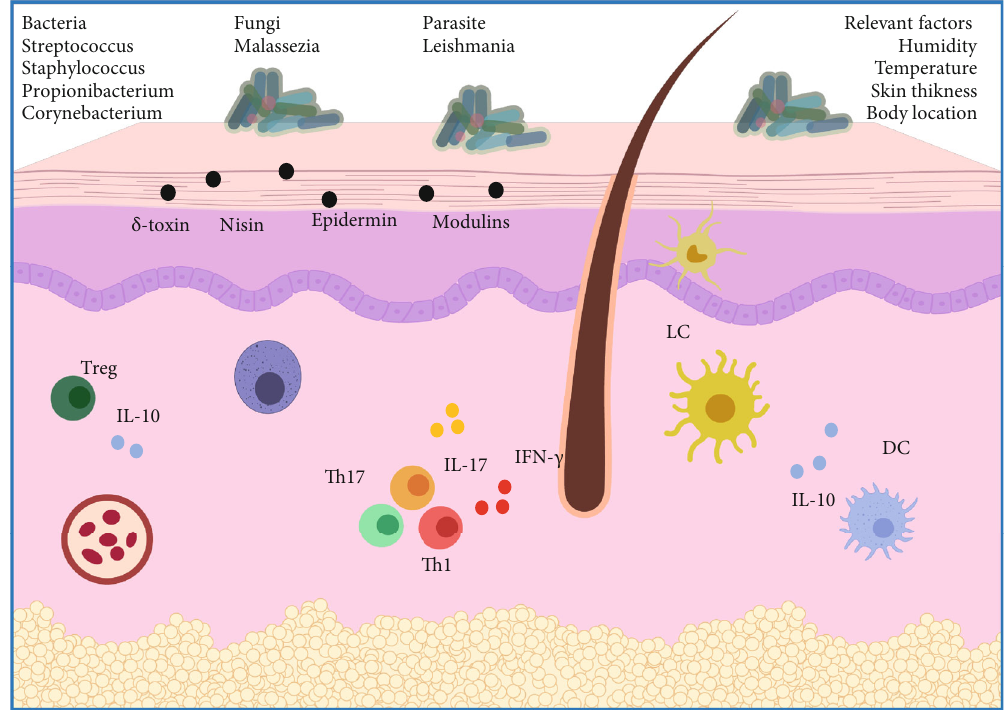
Figure 5: Microbiota, cells, molecules, and environmental factors in skin status. Through the release of mediators, such as modulins, and the participation of immune cells and molecules, the skin controls its own homeostasis. Environmental factors like pH, humidity, temperature, skin thickness, and body location actively a ff ect the composition of this